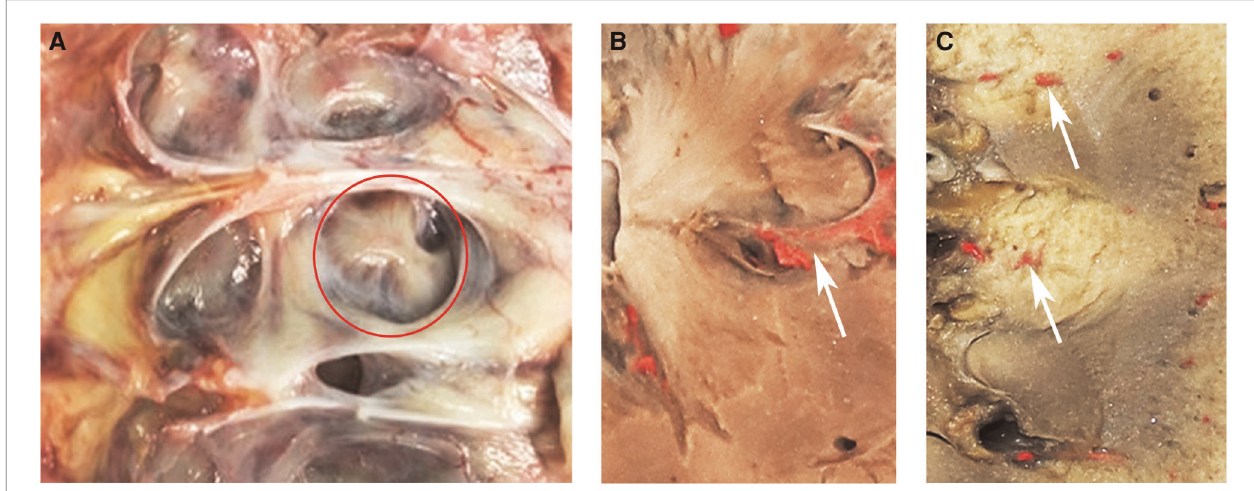
FIGURE 1 | ( A ) FRP in a nephrectomy specimen. There are two papillae entering a compound calyx. The red circle indicates the FRP. ( B ) FRP in a human kidney. There are two renal pyramids fused into one FRP. The white arrow indicates the interlobar blood vessel distributed in the FRP. ( C ) NRP in a human kidney. The white arrow indicates the interlobar artery distributed in the renal column. FRP, fused renal pyramid; NRP, normal renal